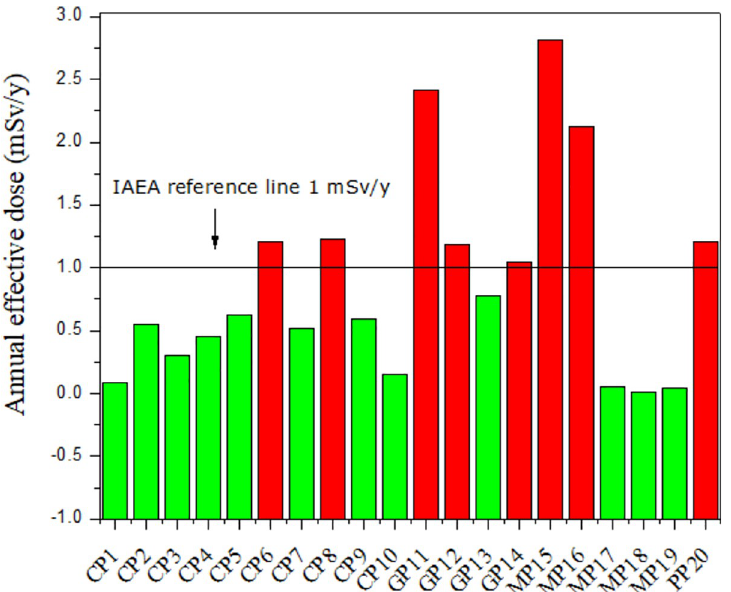
Fig 7. Annual effective dose for the 20 scalar pendants demonstrating measurable gamma activity.